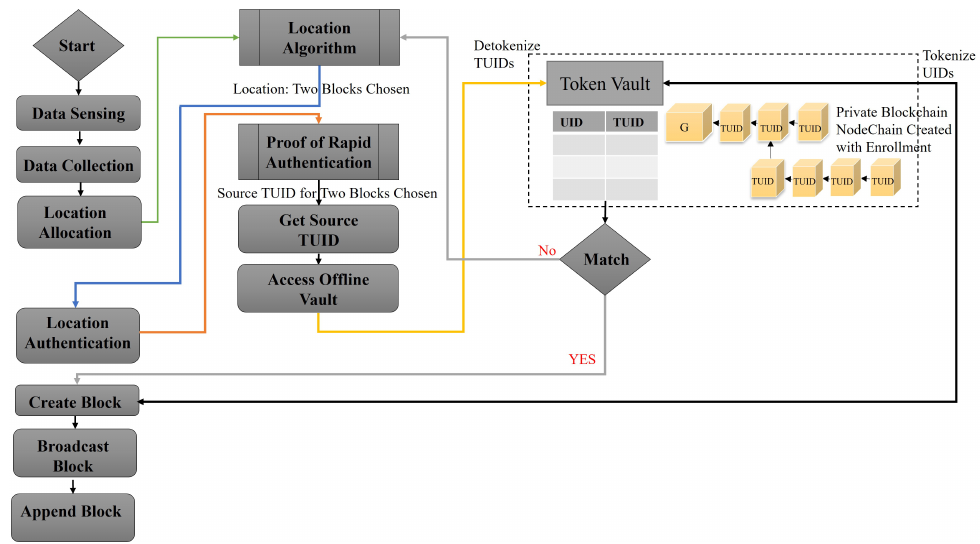
Figure 7. NodeChain Proof of Rapid Authentication.